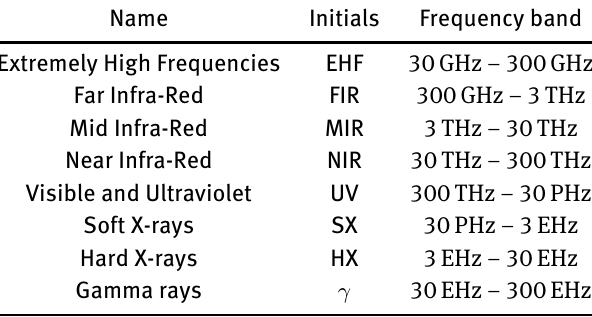
Table 6: Ranges of frequencies in which the theory in this paper cannot be